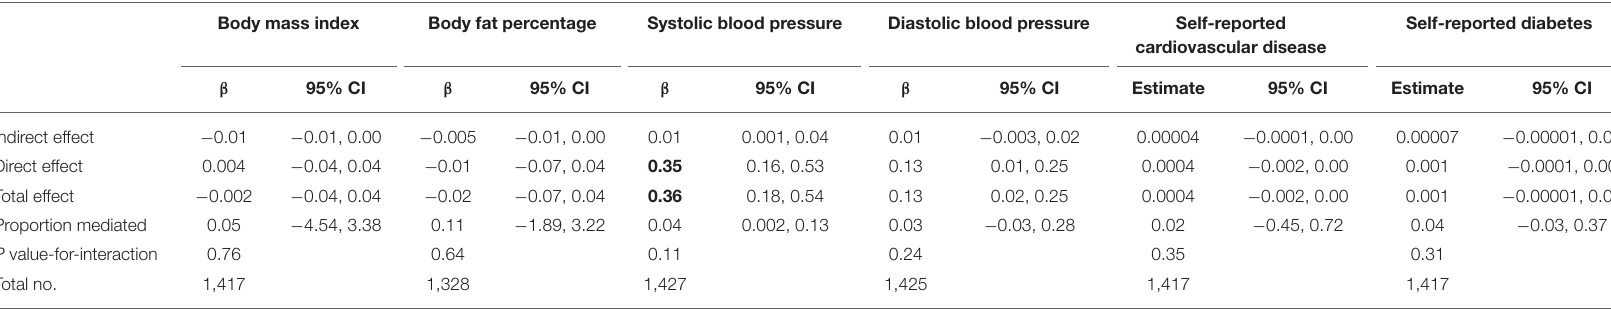
TABLE 3 | Adjusted † total effect, direct effect of relative household income deprivation (effect not via mediator) and indirect effect of cortisol (mediator) with CVD risk factors (BMI, body fat percentage, and systolic and diastolic blood pressure) as well as self-reported CVD and diabetes ∗ for 1,562 Hong Kong Chinese adults from Hong Kong’s FAMILY